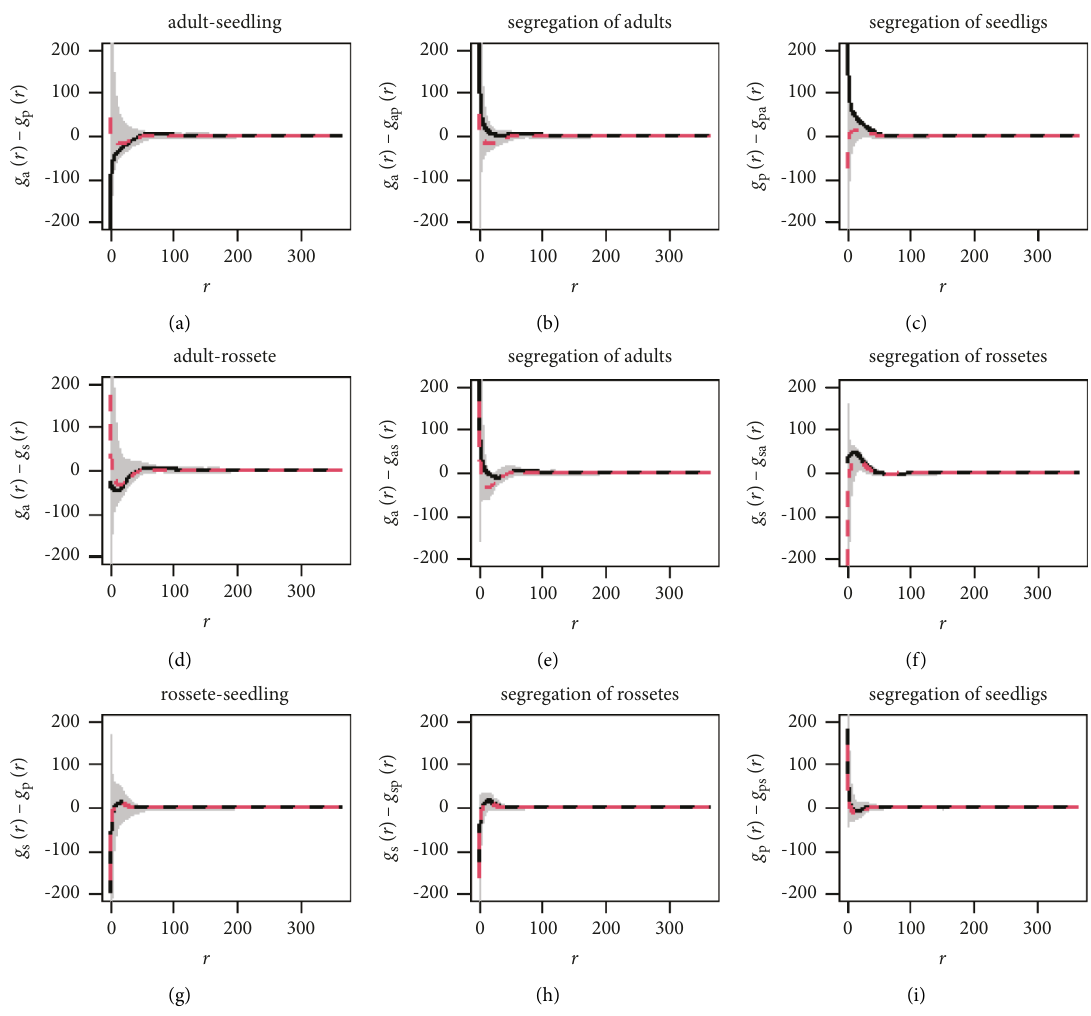
Figure 5: Differences in the aggregation strength of seedlings to rosettes and adults and analysis of the relationship between stages. The figure illustrates differences between the pair correlation function g ( r ) using a randomly labeled null model, where subscripts “ p, ” “ s ,” and “ a ” represent seedlings, rosettes, and adults of C. parvifrons , respectively. Simulation wraps (gray region) were constructed employing 399 simulations of the random labeling model. Solid and dotted lines denote the observed and expected patterns, respectively. (a) Adult- seedling, (b) segregation of adults, (c) segregation of seedlings, (d) adult-rosette, (e) segregation of adults, (f) segregation of rosettes, (g) rosette-seedling, (h) segregation of rosettes, and (i) segregation of